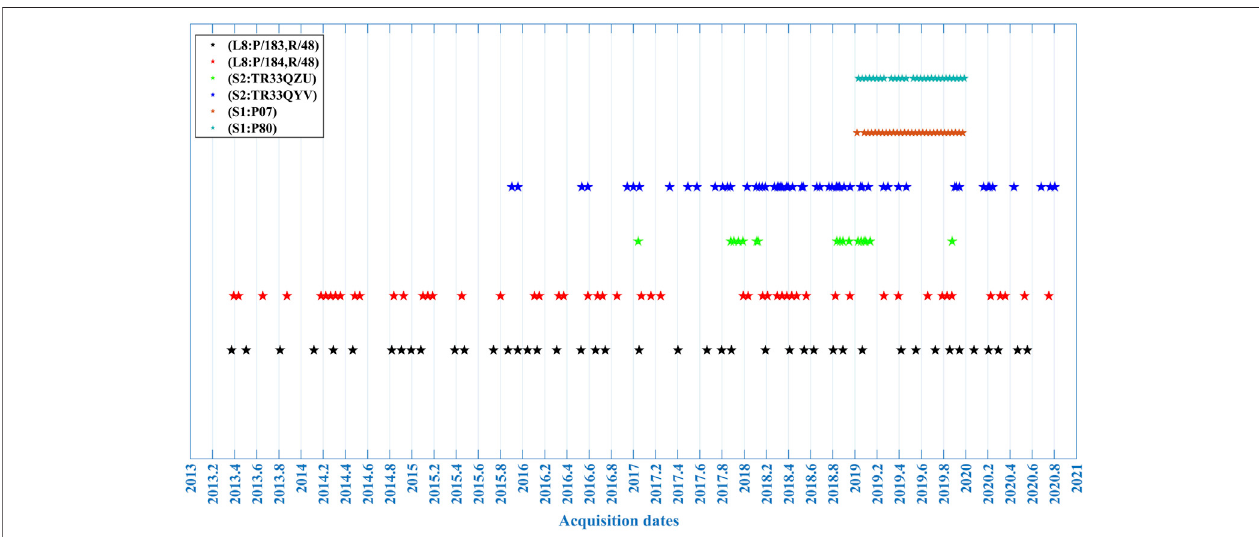
FIGURE 2 | Temporal distribution of data used in the study. Landsat-8 frames (P:183/R:48) and (P:183/R:48) (43 and 52 scenes, respectively), Sentinel-2 tiles (TR33QYV and TR33QZU) (56 and 17 scenes, respectively), and Sentinel – 1 descending orbits (07 and 80) (30 and 29 scenes, respectively). The cloud cover threshold for Sentinel-2 tile TR33QZU was set to 20% due to the cloud and dust. Detailed acquisition information is listed in Supplementary Tables S1 – S5 .